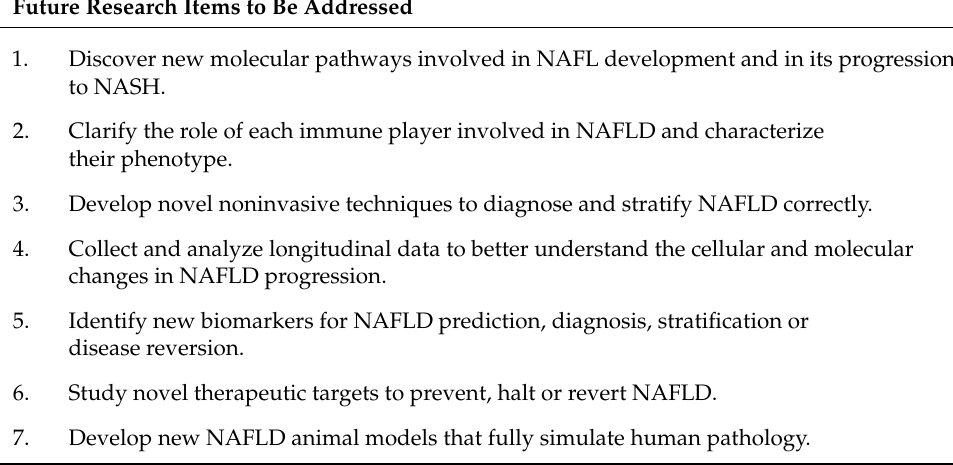
Table 2. Future research topics proposed to improve NAFLD diagnosis and treatment. Future Research Items to Be